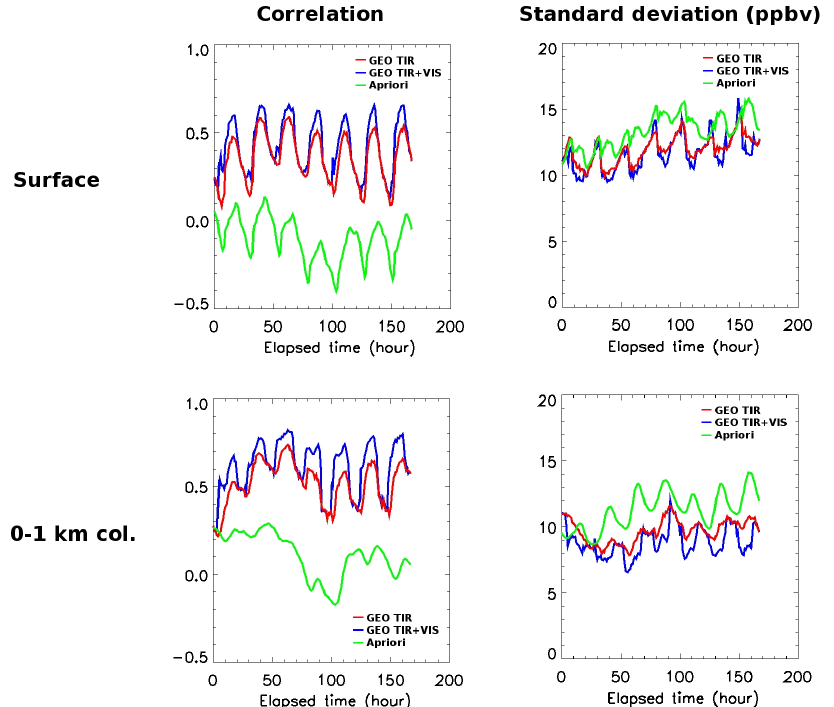
Figure 8. Time series of ozone correlation (left column, dimensionless) and standard deviation (right column, ppbv) between GEO TIR (red lines), GEO TIR + VIS (blue lines) and the reference state. This is calculated for all pixels of the red square domain (see Fig. 2) for the period between 9 to 15 July 2009. The green line shows the results obtained with the a priori. The first row corresponds to the surface ozone results and the second row corresponds to the 0–1km ozone column results.